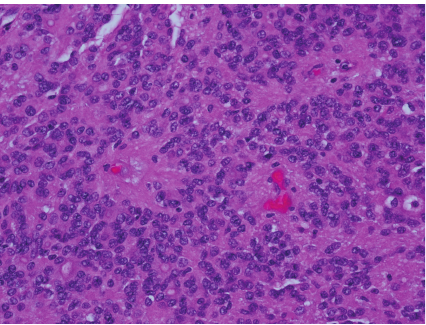
Figure 2: Histologic features of the ependymoma component with rosette